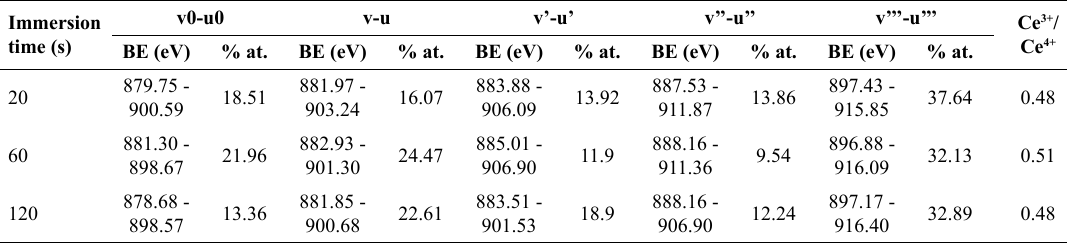
Figure 7. Representative XPS core level for the Ce3d region of the conversion film obtained after 60 s of immersion. Table 2. XPS fitting parameters for the Ce3d core levels of the cerium-coated AZ91D